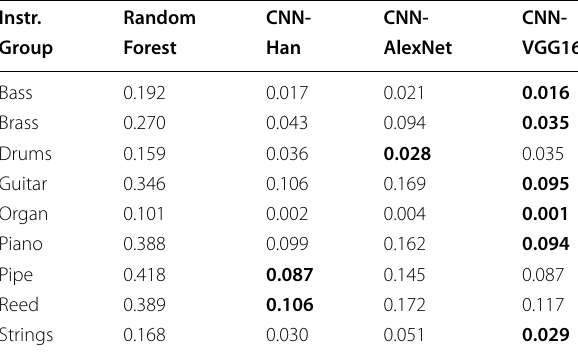
a CNN-Han is better than CNN-VGG16 for pipe at the 6th position after the fix point